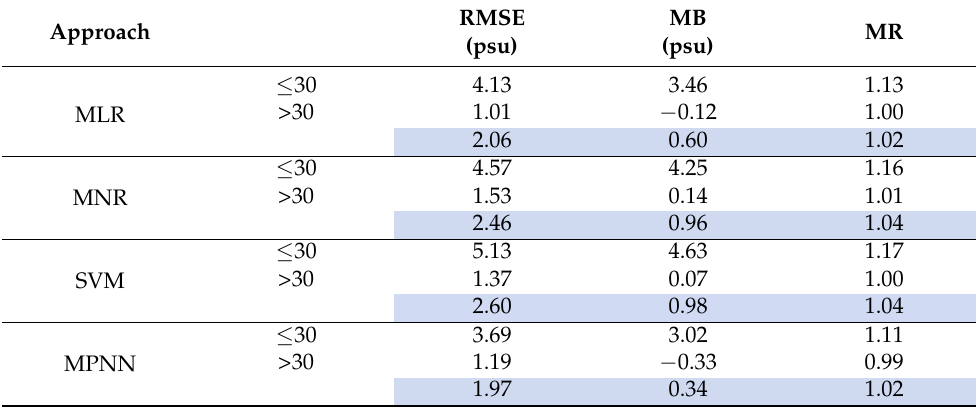
Figure 9. Performance of the SSS model in quantifying SSS in the area around the Mississippi-Atchafalaya estuary in the northern GOM. ( a ) Comparison between field-measured SSS and MODIS-derived modeled SSS, the red dots on the X -axis indicate that there are no corresponding MODIS-derived SSS; ( b ) spatial distributions of the MODIS-derived SSS along the cruise track in ( a ), colored by field-measured value, white color indicates no MODIS data. Table 6. Model comparison in independent validation of cruise GM0606, the overall result of each cruise was listed with blue background.